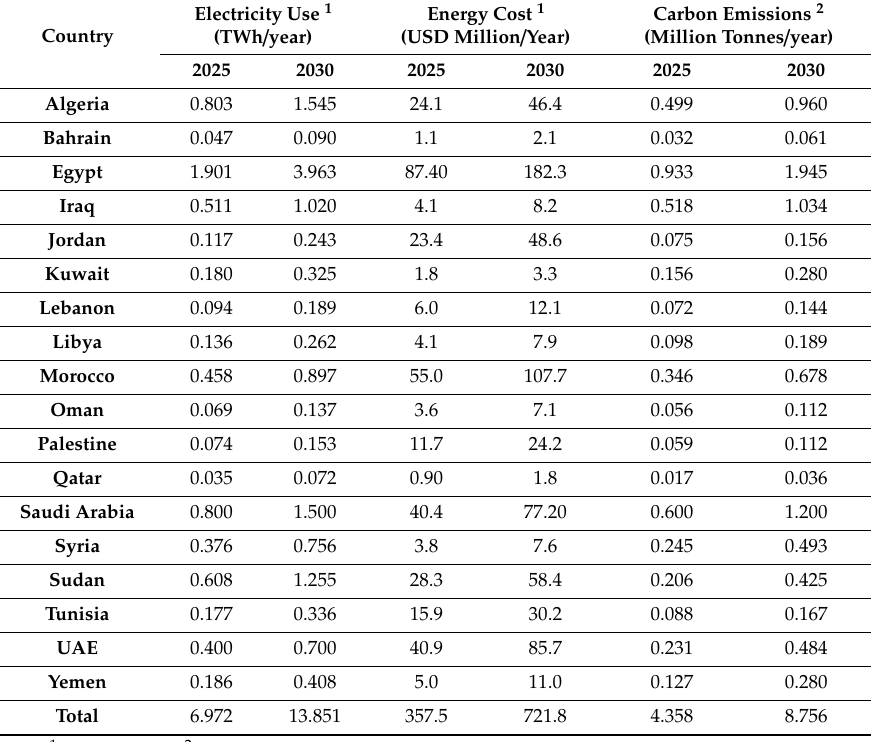
Table 14. Potential annual benefits attributed to MEPS for refrigerators in the Arab region. Country